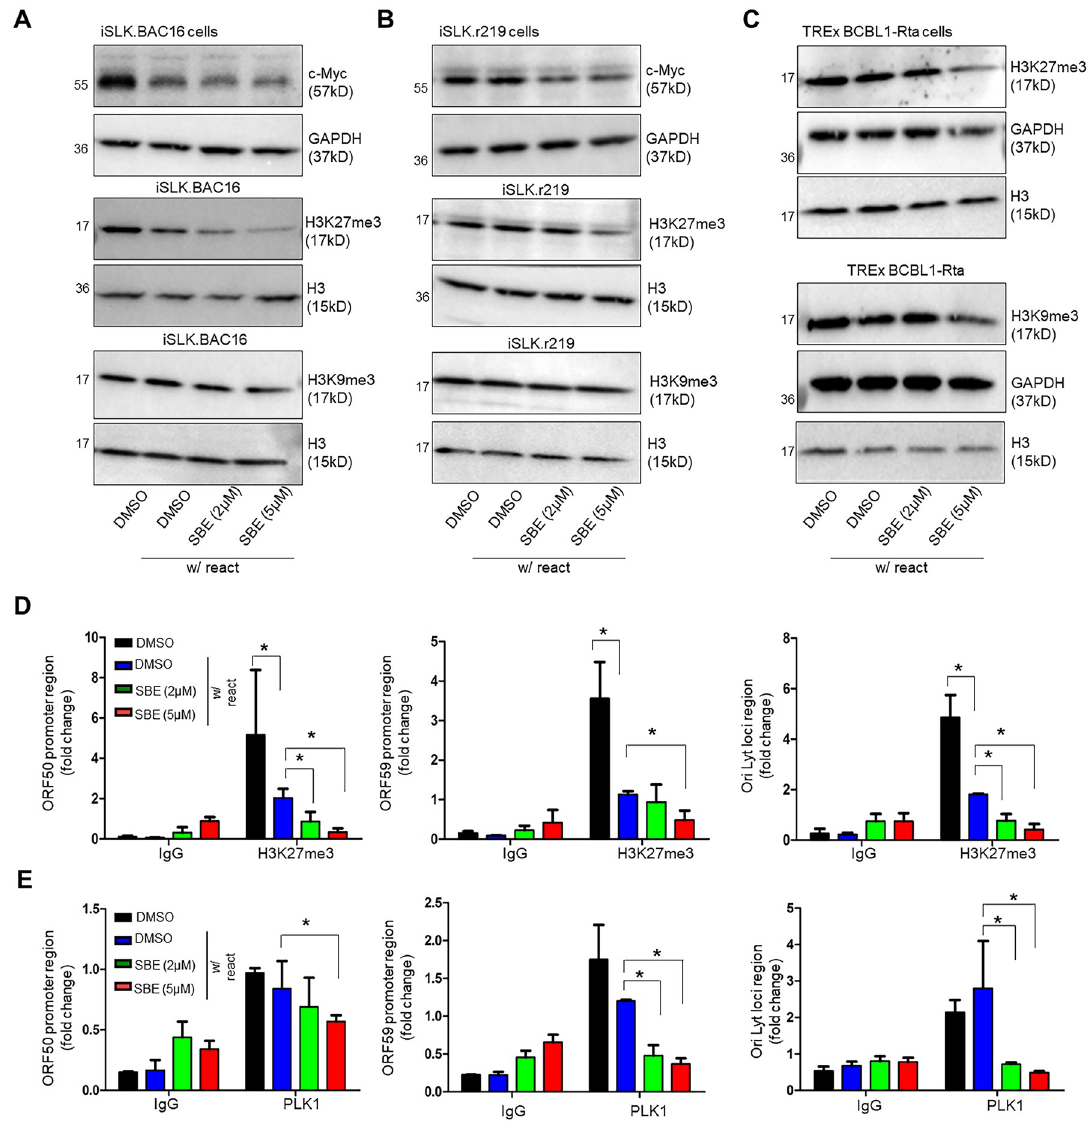
Fig 4. PLK1 inhibition destabilizes c-Myc and reduces H3K27me3. (A-C) Protein level of c-Myc, H3K27me3, H3K9me3, or H3 in iSLK.BAC16 (A), iSLK.r219 (B), or TREx BCBL1-Rta (C) cells was measured by immunoblotting. These cells were treated with SBE or DMSO, and Dox to induce KSHV reactivation. GAPDH was used as the loading control. (D, E) TREx BCBL1-Rta cells were treated with SBE or DMSO, and Dox to induce KSHV reactivation. Cell lysates were prepared and subjected to ChIP assay by using antibodies against H3K27me3, PLK1, or a mouse IgG as a negative control. Precipitated DNA samples were further analyzed by qPCR by using primers targeting promoter region of KSHV lytic genes (ORF50, ORF59) and OriLyt, and normalized to IgG control. Results were calculated from n = 3 independent experiments and presented as mean ± SD ( � p < 0.05; two-tailed paired Student